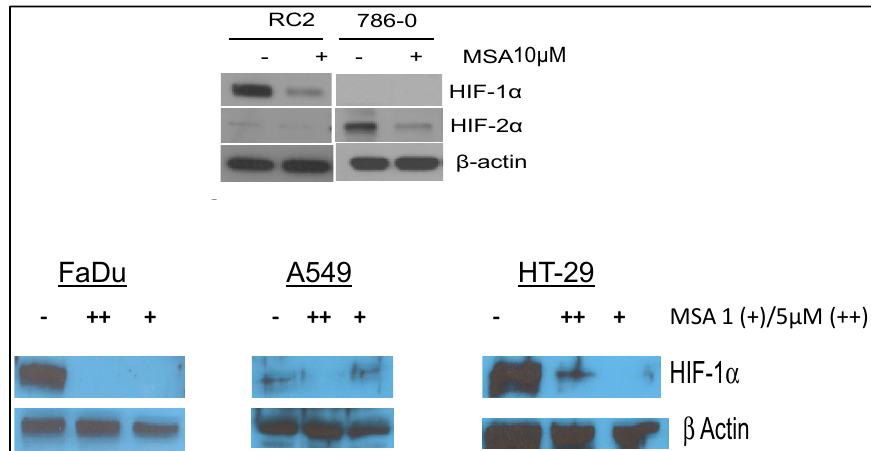
Figure 2. Constitutively expressed HIFs are selenium targets [20,32]. Effects of methylseleninic acid (MSA), the active moiety of methylselenocysteine (MSC) or seleno- L -methionine (SLM), on the expression levels of constitutively expressed HIFs in RC2 and 786.0 renal cell carcinoma, and on HIF1 α head and neck in FaDU, lung carcinoma, A549, and colorectal carcinoma cell lines. RC2 and 786.0 cells (adopted from Reference [20]) were exposed to 10 µ M MSA for 24 h, while other cells—FaDu (adopted from Reference [32]), A549, and HT29—were exposed to 0.5% O 2 for 24 h and treated with different MSA concentrations. Cells were lysed rapidly on ice and analyzed for HIF expression by Western blot [20,32].